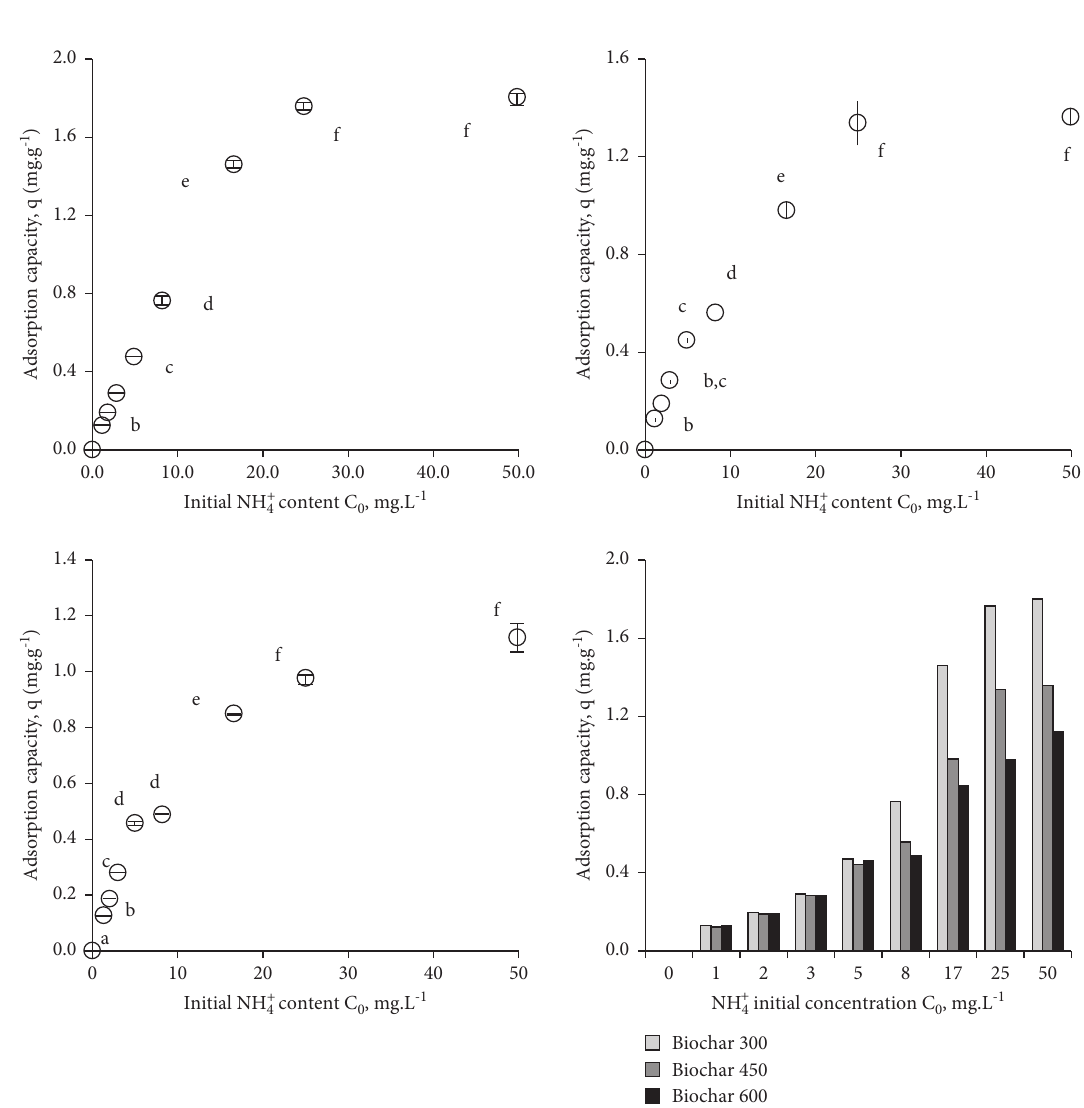
Table 3: Parameters of NH + adsorption isothermal models. 4 Parameters of the Langmuir model